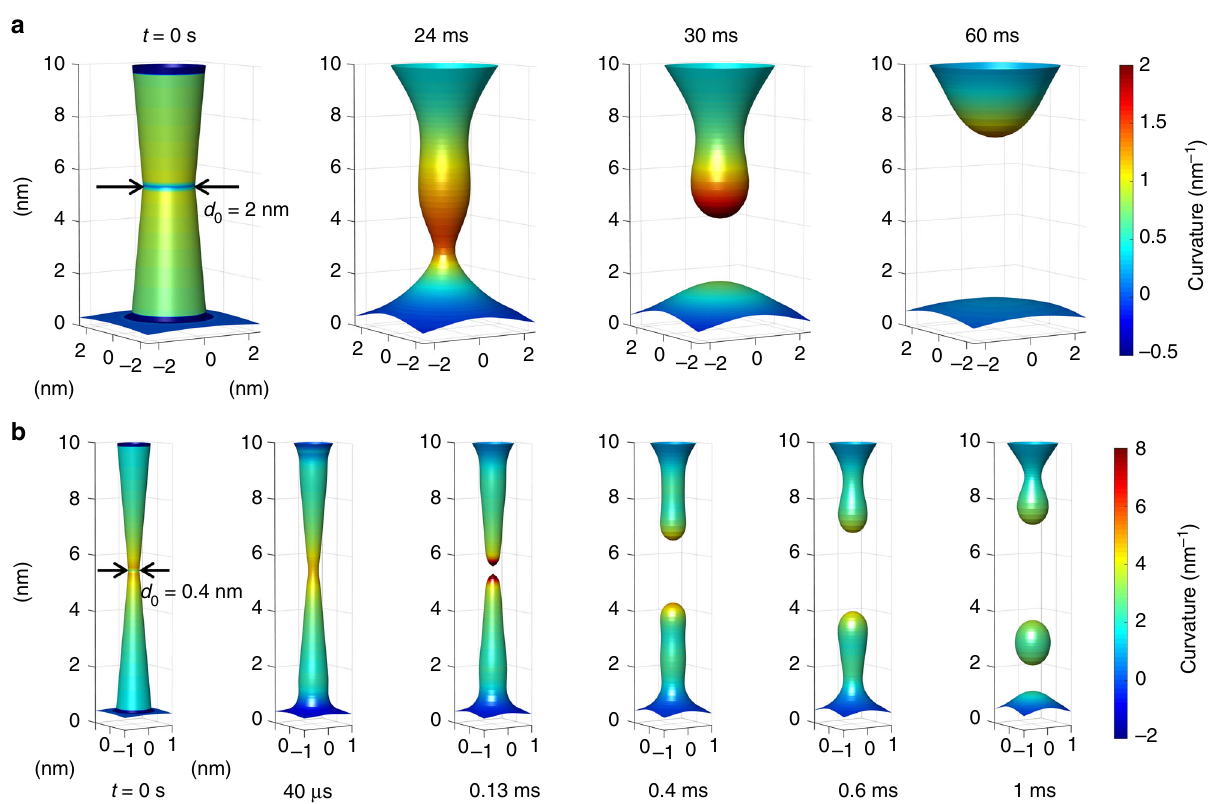
Fig. 3 Morphological changes induced by surface diffusion. a Simulation results of the surface diffusion equations, indicating the rearrangement of a Ag CF with initial diameter d 0 = 2 nm at increasing times, namely t = 0, 24 ms, 30 ms, and 60 ms. b Same as a , but for a CF with an initial diameter d 0 = 0.4 nm at times t = 0, 40 μ s, 0.13 ms, 0.4 ms, 0.6 ms, and 1 ms. For both cases, the CF length is 10 nm, equivalent to the thickness of the insulating layer between two planar electrodes. The color in the fi gures indicates the surface curvature, where surface points with higher curvature are more likely to induce surface diffusion, thus providing a suitable spot for CF rupture. The CF lifetime decreases from around 20 ms ( a ) to about 0.13 ms ( b ) as d 0 is reduced from 2 nm to 0.4 nm. The ovulation effect in b , where nano-clusters result from the disconnection of a thin CF, is consistent with in situ TEM observations of Ag nano- clusters evolving from Ag nanoscale CFs d 0 = 0.2 nm and h = 10 nm, to 2.56 × 10 5 s (about 3 days, in line with the measured lifetime of AgNWs 36 ) for the fi lament with d 0 = 80 nm and h = 4 μ m.